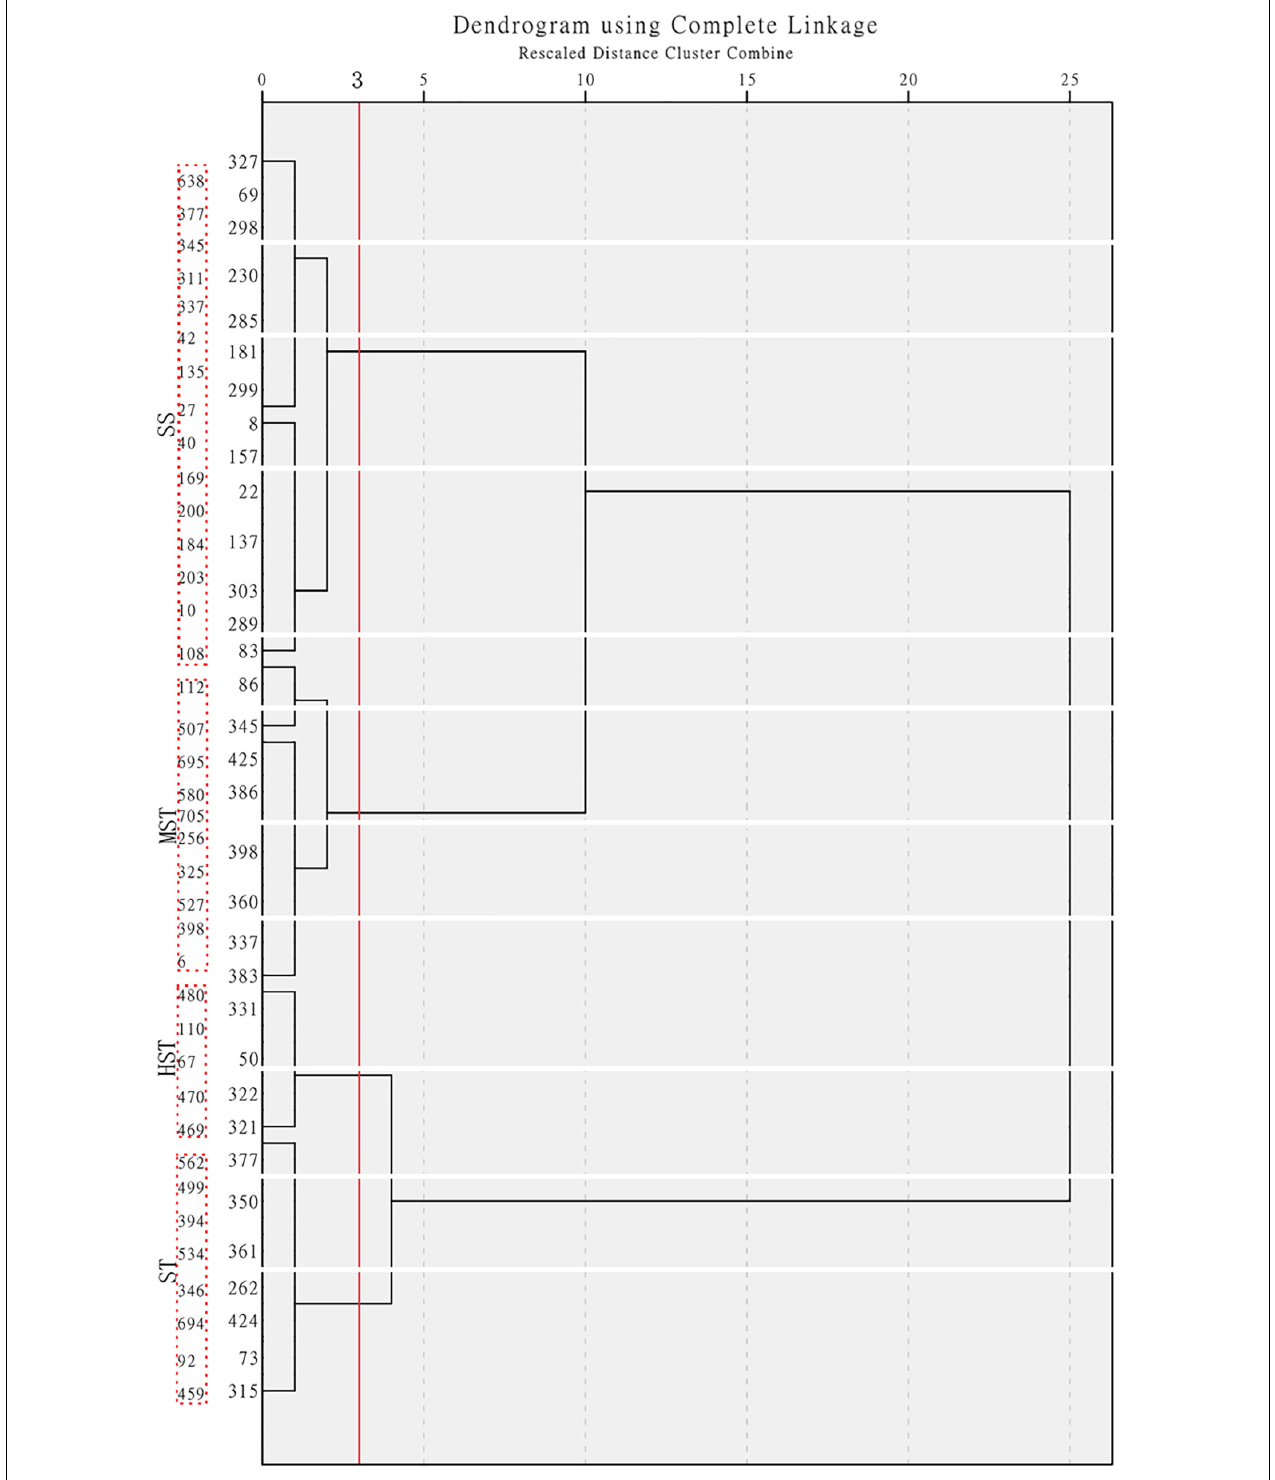
FIGURE 2 | Hierarchical cluster analysis based on the Furthest Neighbor to evaluate the salt tolerance of 438 B. napus inbred lines. HST, high salt tolerance; ST, salt tolerance; MST, moderately salt tolerant; and SS, salt sensitive.